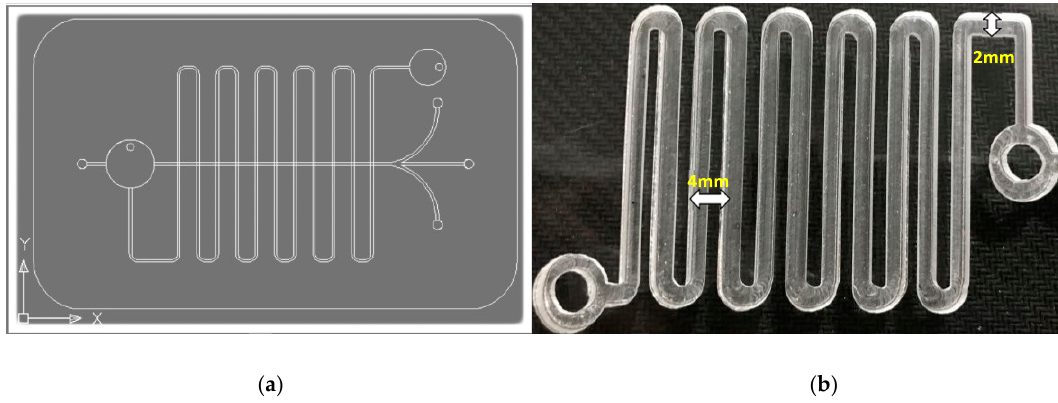
Figure 3. ( a ) Design of the microchannel features using computer-based tools; ( b ) microchannel features transferred to PMMA using 2 mm drill with the help of CNC Micro Milling